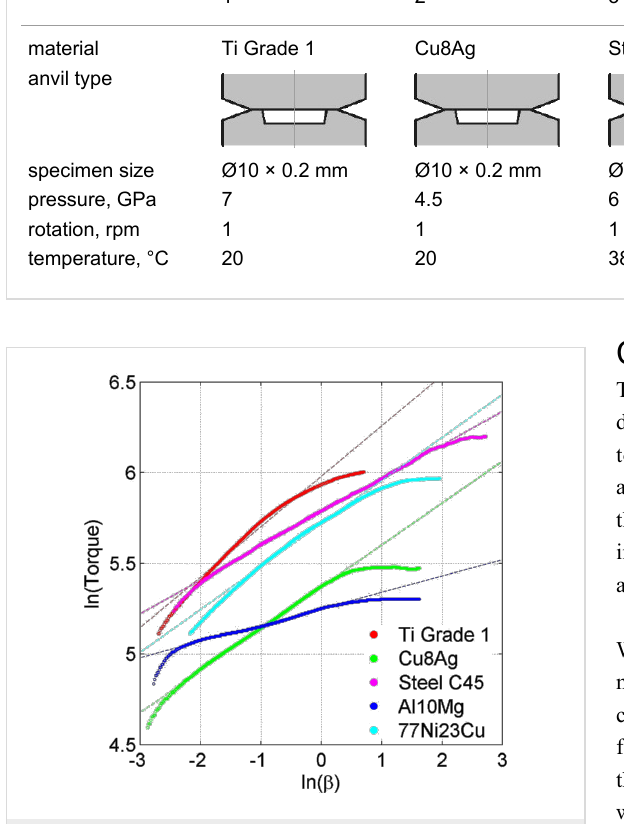
Figure 6: Log–log plot of the dependence of the torque on β , obtained from experimental data.